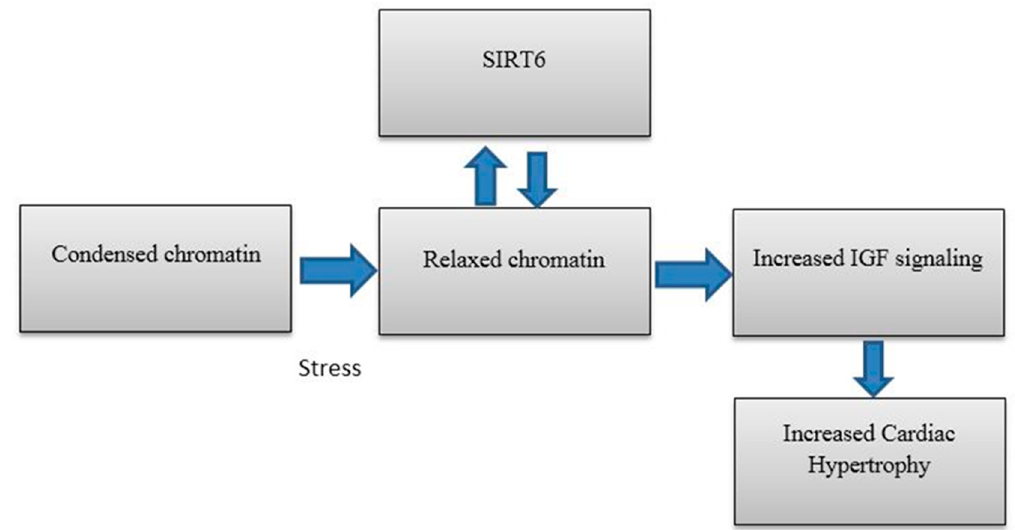
Figure 3. During normal function, SIRT6 is responsible for inhibiting the expression of Insulin-like growth factor 1 (IGF) signaling genes. Under stressed conditions, however, SIRT6 in cardiac tissue is reduced leading to an increase in IGF signaling and an increase in cardiac hypertrophy and multiple complications (adapted from reference [96]).